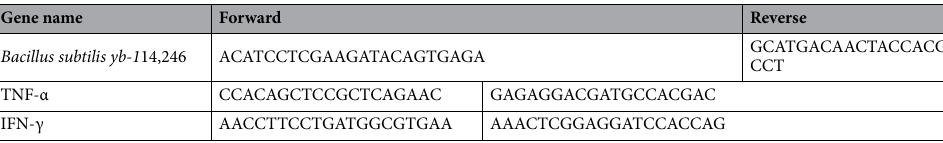
Table 4. All of the PCR primers. Tumor necrosis factor-α (TNF-α, interferon-β